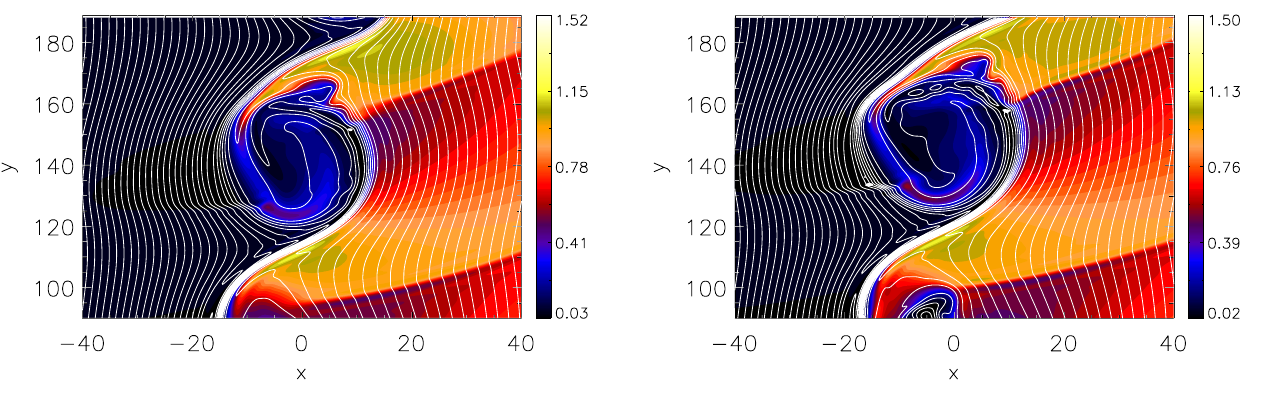
Fig. 4. Shaded density isocontours at t = 160, V 0 = 6. White curves represent magnetic field lines in the (x,y)-plane.